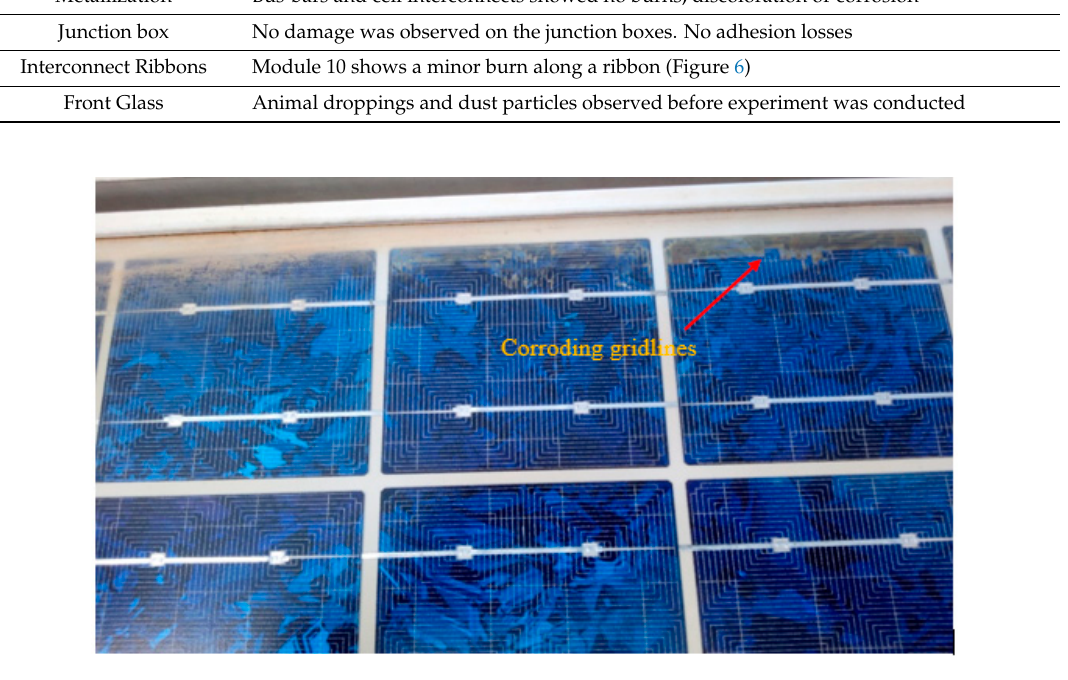
Figure 5. Module 12, indicating corroding gridlines.